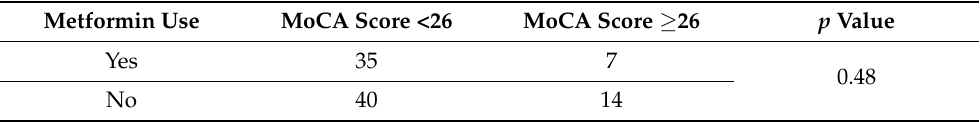
Table 2. Distribution of metformin use according to cognitive functions.